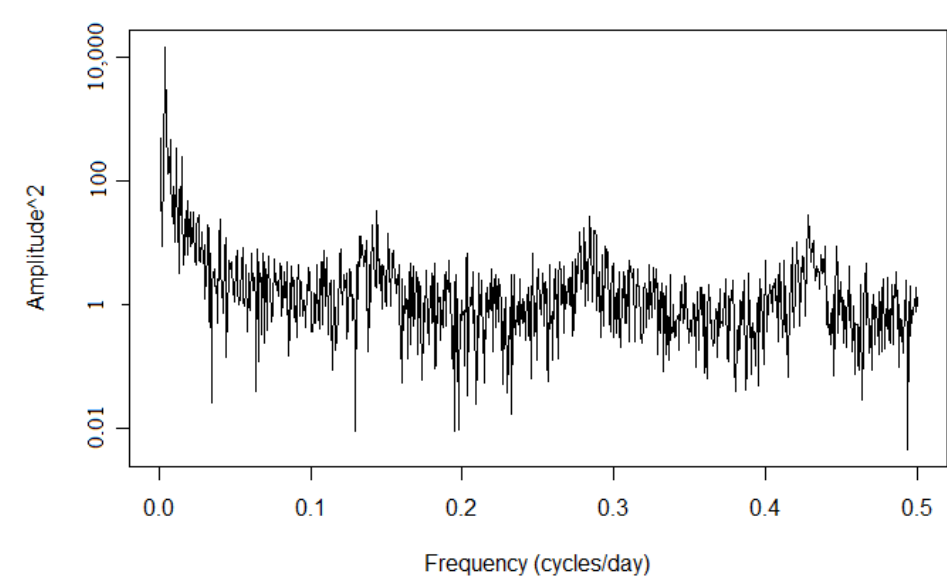
Figure 6. Power spectrum log–log for